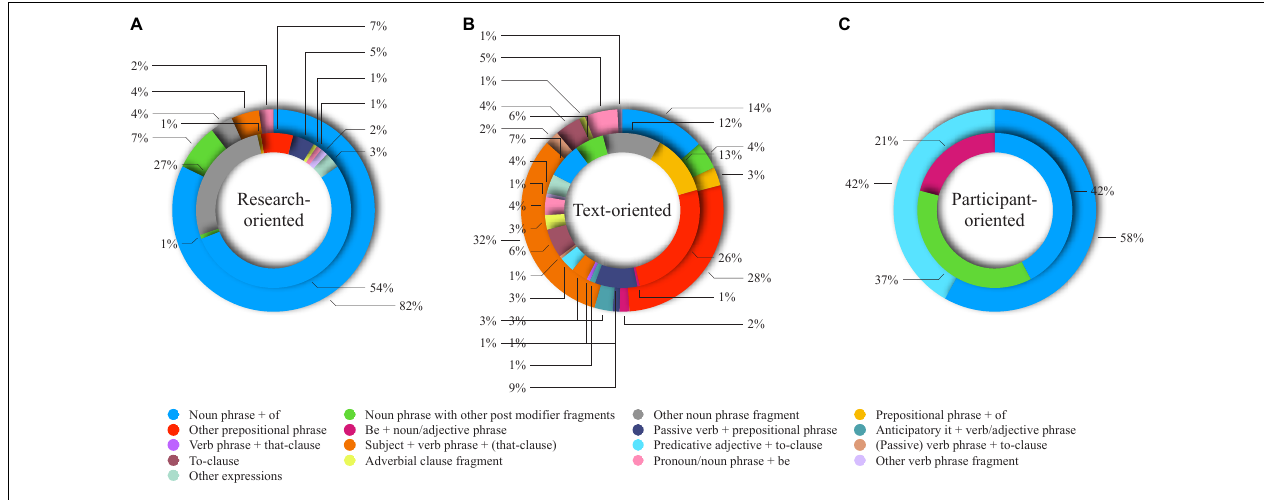
FIGURE 1 | Structural distribution of BUDs in functional major categories (an inner circle: CUC BUDs; an outer circle: AUC BUDs; (A) research-oriented; (B) text-oriented; and (C) participant-oriented). identified with many other pairs of BUDs within description bundles commonly used by the Chinese and American students, respectively, including features of the and properties of the , characteristics of the and the nature of , and the framework of and a model of